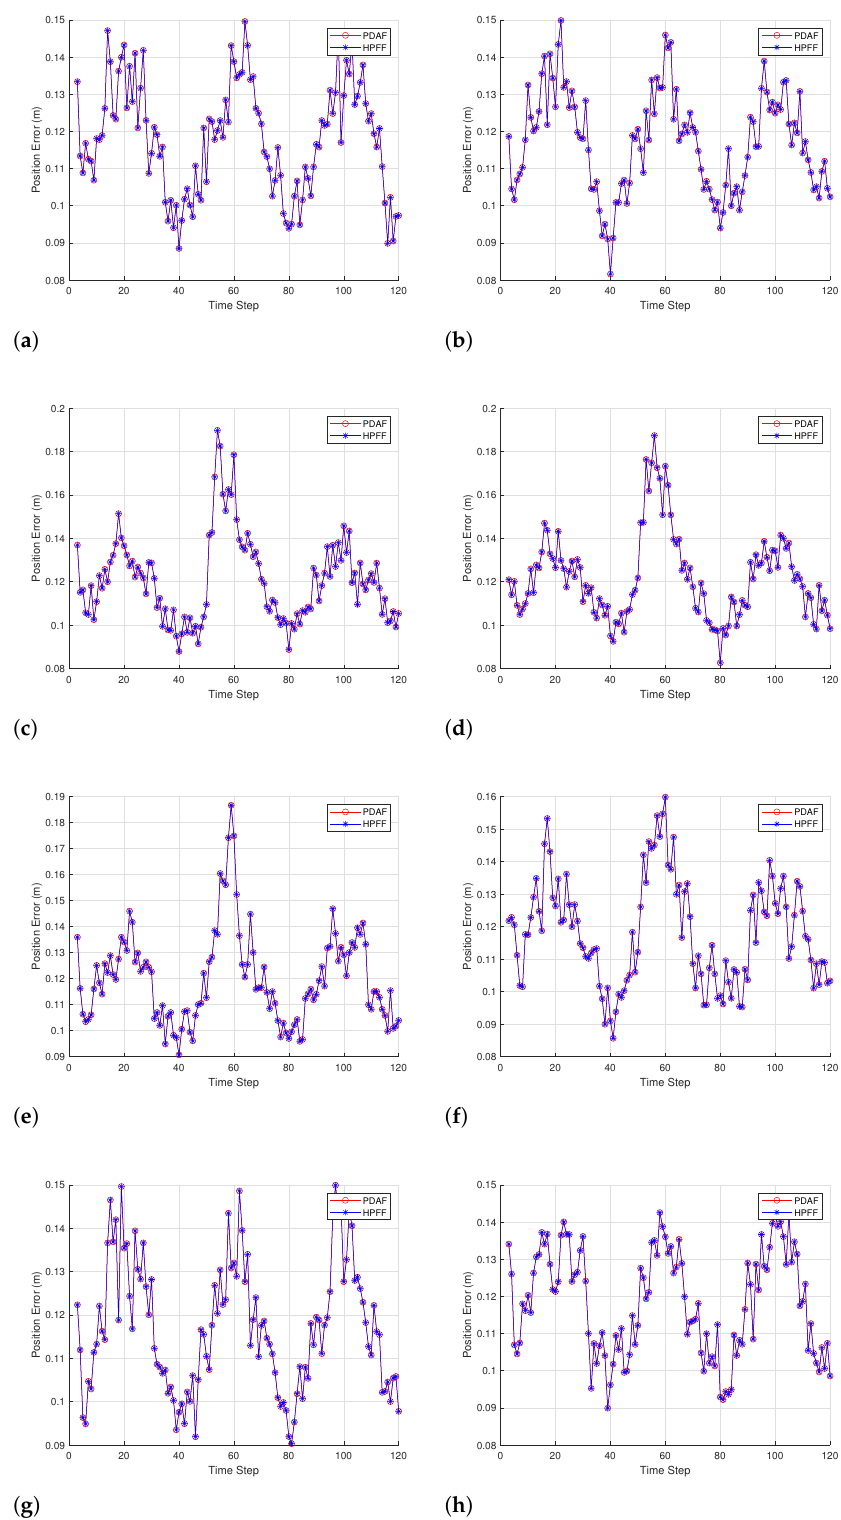
Figure 6. RMS position errors of indoor localization using PDAF and HPFF under temporary NLOS conditions in which the transmitter (FN) in a NLOS was ( a ) FN1, ( b ) FN2, ( c ) FN3, ( d ) FN4, ( e ) FN5, ( f ) FN6, ( g ) FN7, and ( h )